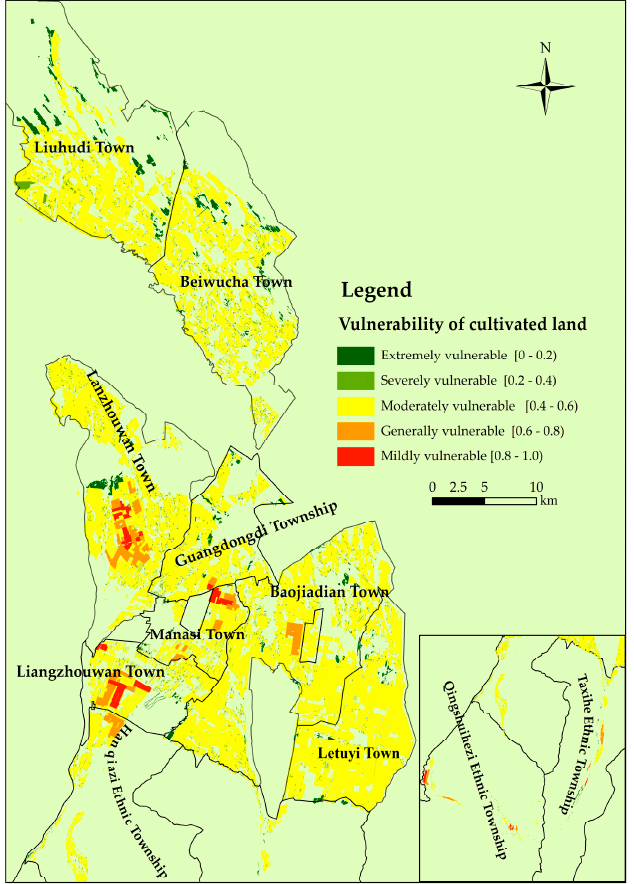
Figure 4. Spatial distribution of cultivated land vulnerability.